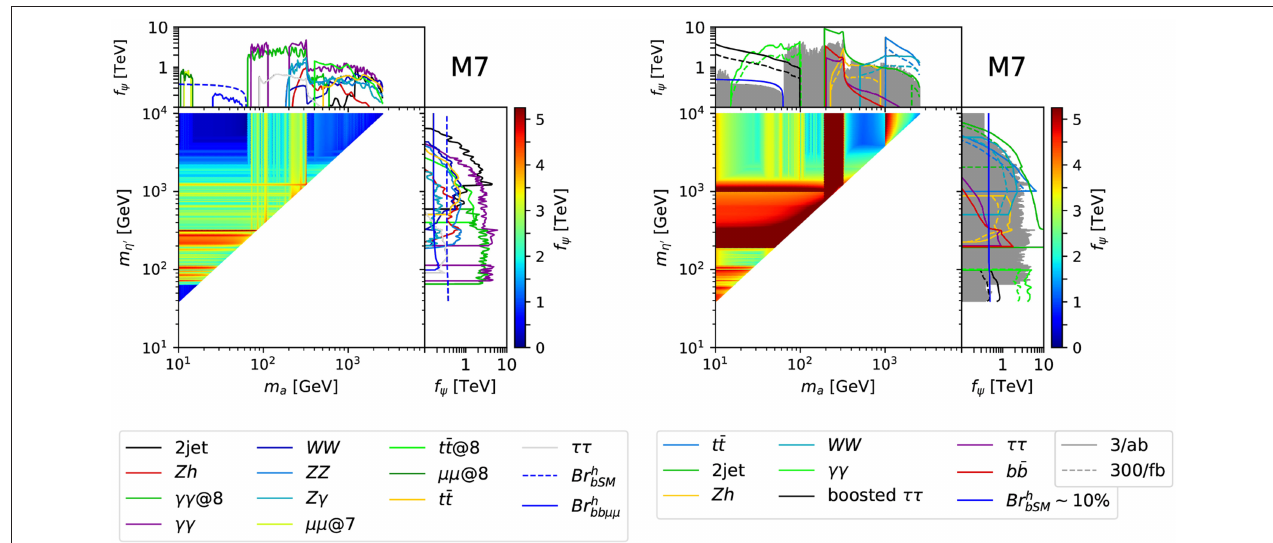
FIGURE 4 | Same as Figure 3 , for the model M7, based on the EW coset SU(5) /